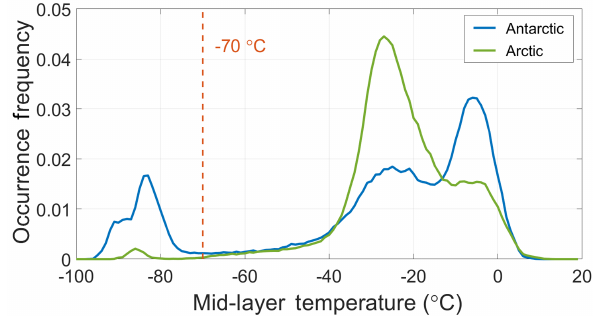
Figure 5. Occurrence frequency of mid-layer temperatures for V4 aerosol layers detected poleward of 50 ◦ during PSC season; June– September 2008 for the Antarctic and December 2007–February 2008 for the Arctic at